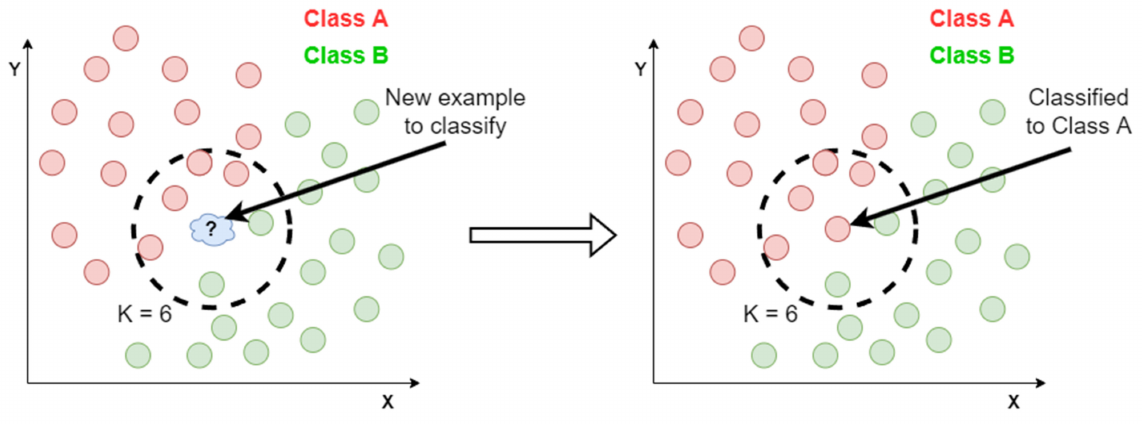
Figure 4. The idea of K-Nearest Neighbor